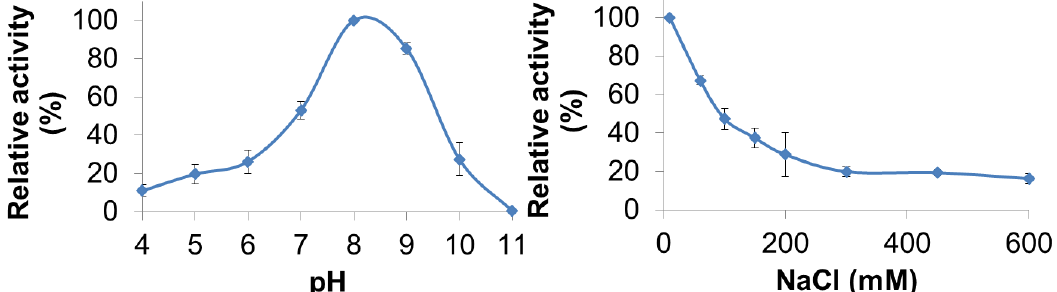
Figure 3. Effect of pH and NaCl on the ability of PlyGVE2CpCWB to lyse Clostridium perfringens . Top panel shows the activity of the endolysin over a range of pH values. Bottom panel shows the activity of the endolysin over a range of NaCl concentrations. Lytic activity of the endolysin was determined by the turbidity reduction assay and all activities were normalized to the maximal activity achieved